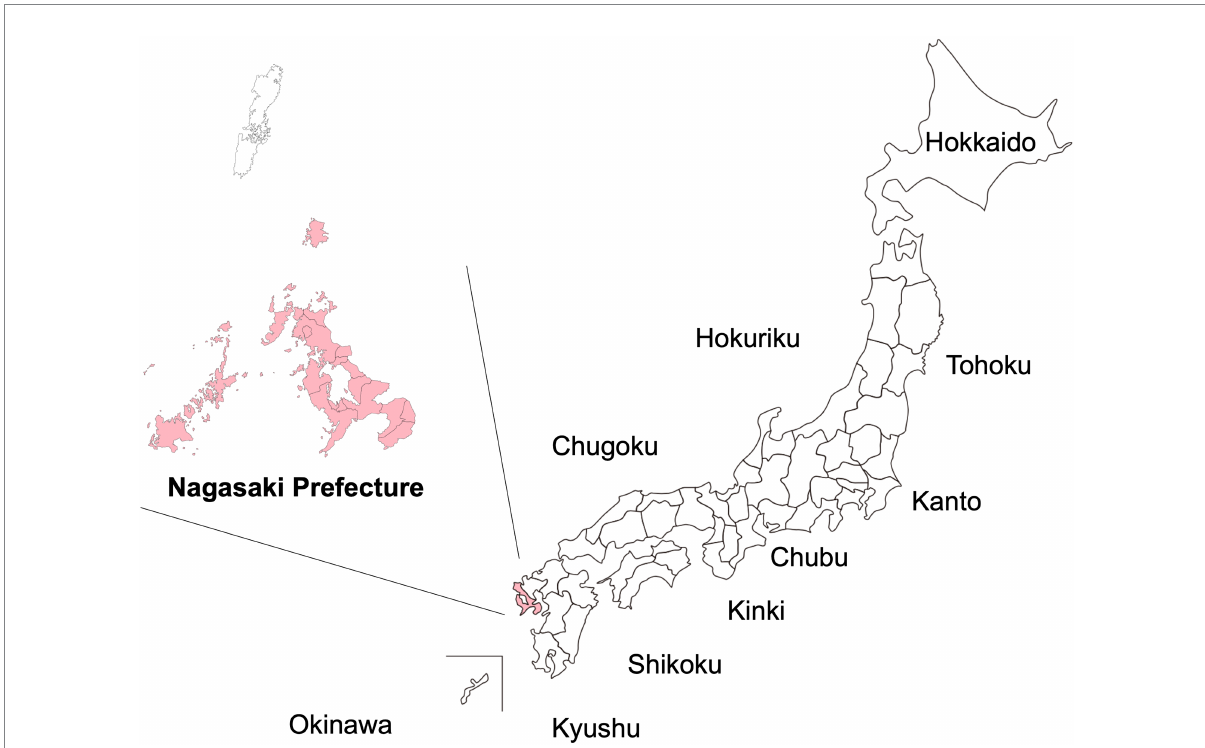
FIGURE 1 Location of the study area in Nagasaki Prefecture, Japan. The present study was carried out in Nagasaki Prefecture, which is located in the most western part of Japan. Only the part of Nagasaki Prefecture colored pink is included in this study. (Tsushima islands are not